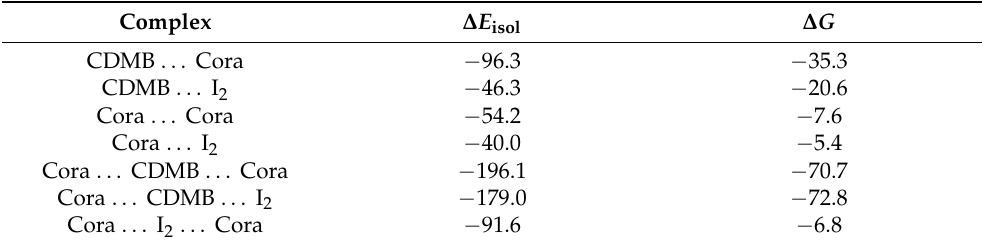
Table 2. The energies (in kJ/mol) of the most energetically favorable structures as found during searches of the potential-energy surface. See the text for